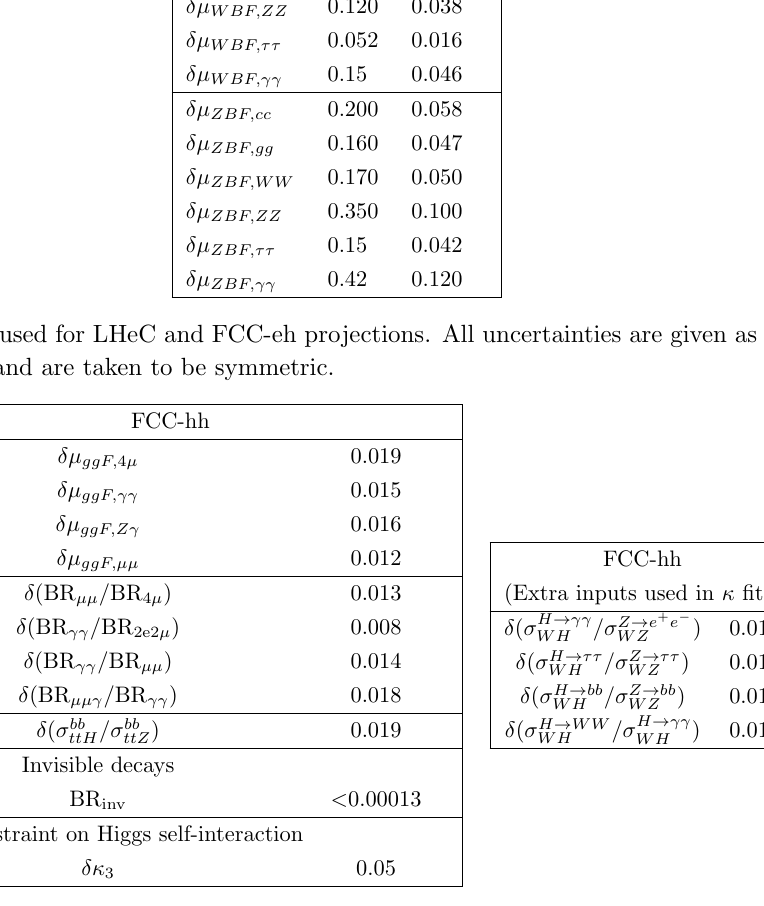
Table 25 . (Left) Inputs used for FCC-hh. All uncertainties are given as fractional 68% CL intervals and are taken to be symmetric. (Right) Extra inputs used in the (cid:20) (cid:12)t studies.